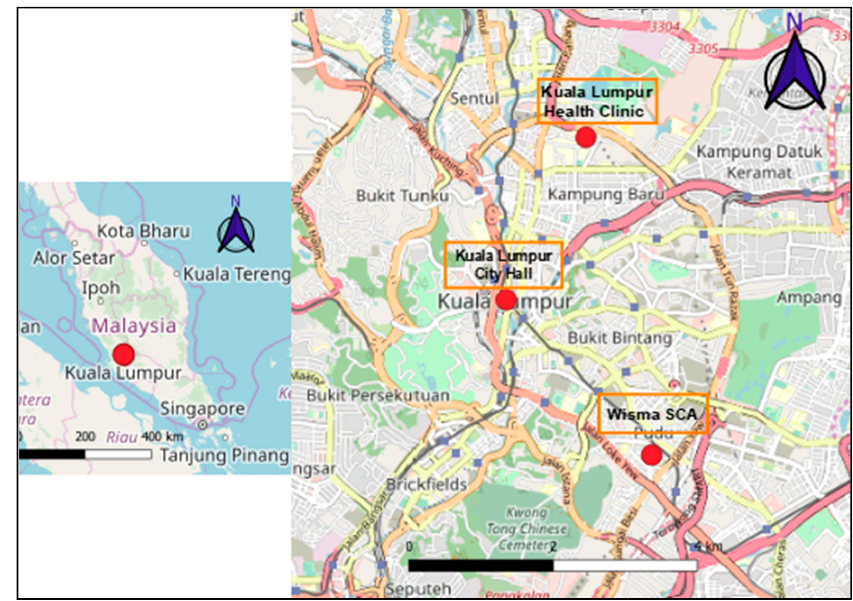
Figure 1. Sampling locations of PM 2.5 in Kuala Lumpur, Malaysia.